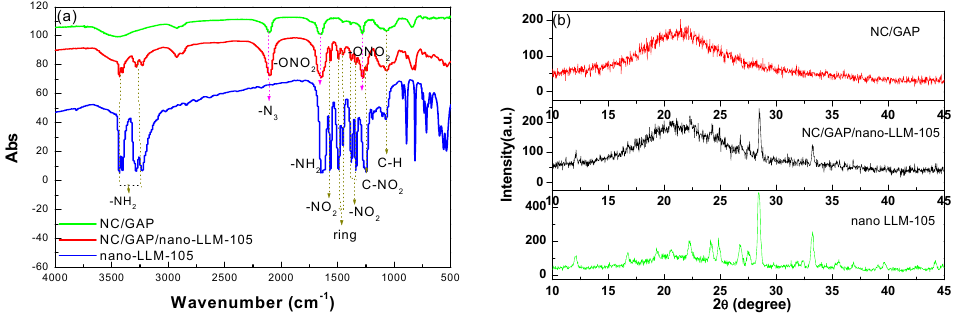
Figure 5 . IR spectra ( a ) and XRD patterns ( b ) of NC/GAP, nano-LLM-105 and NC/GAP/nano-LLM-105.